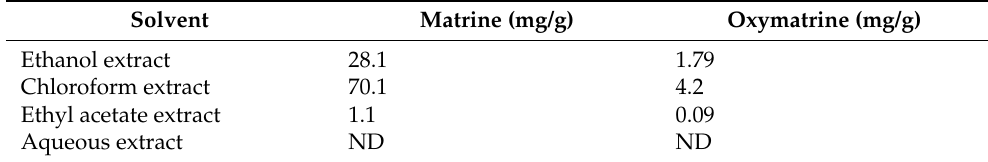
Table 1. Matrine and oxymatrine contents.